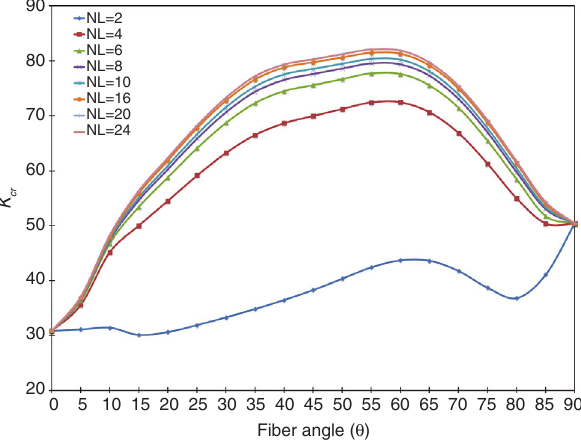
Figure 7 Critical buckling load parameter for simply supported antisymmetric cylindrical skew panel (Ø = 30 ° , α = 0 ° ).